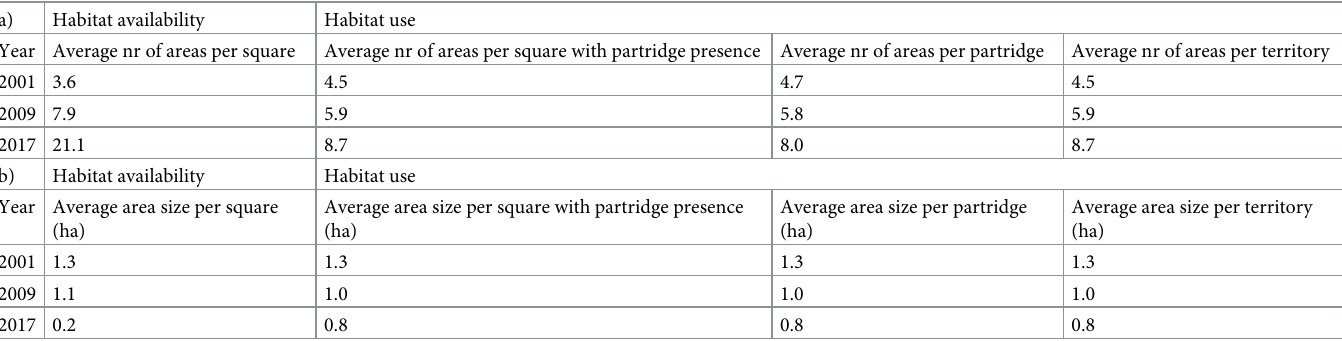
Table 1. Change of habitat diversity for the years 2001, 2009, and 2017.